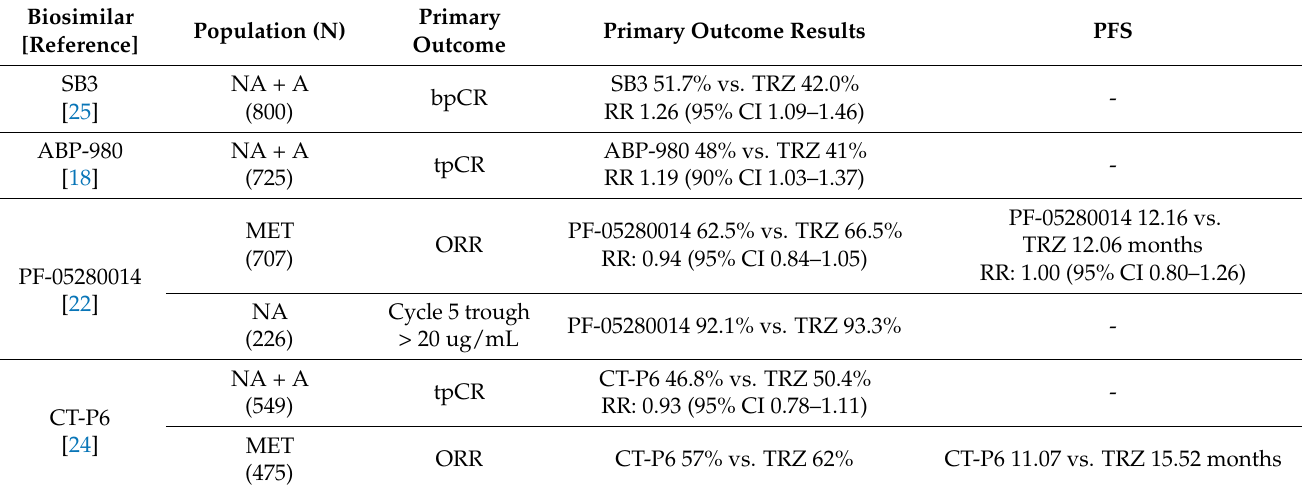
Table 1. Studies to date of trastuzumab